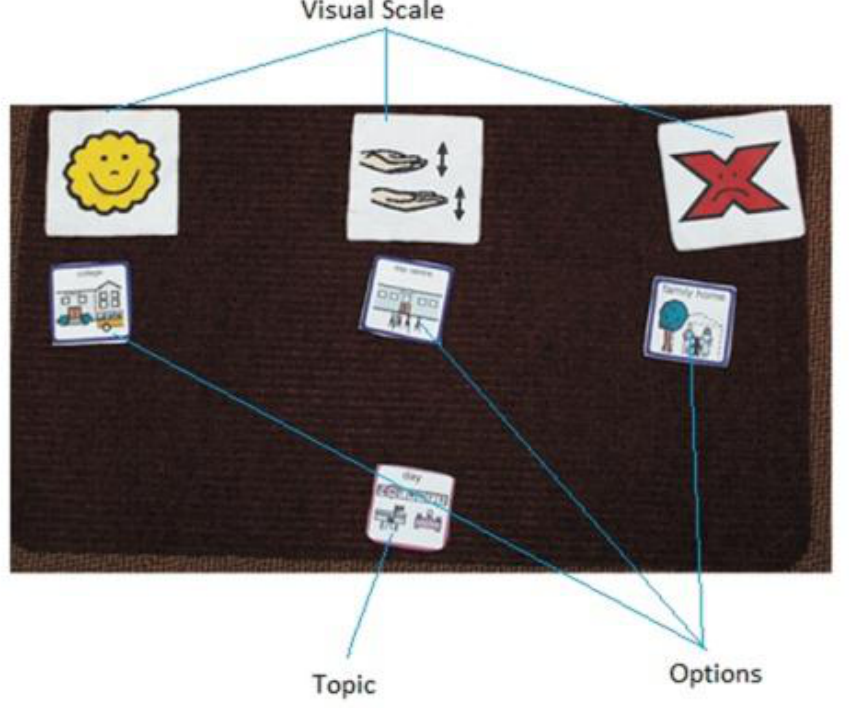
Figure 2. Example of a Talking Mat. The Picture Communication Symbols ©1981–2012 Dynavox Mayer Johnson are used with permission. All rights reserved